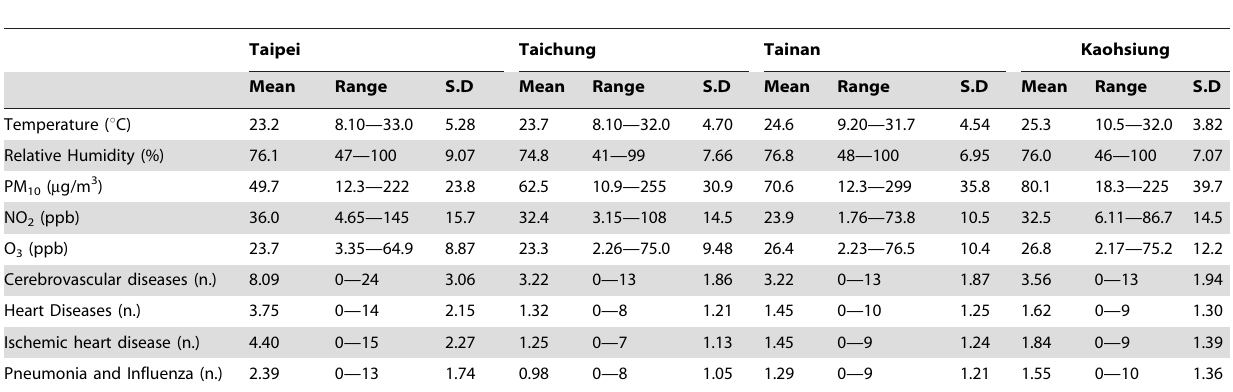
Table 1. Characteristics of the daily ambient environment and cause-specific death in study metropolitans from 1994 to 2007.